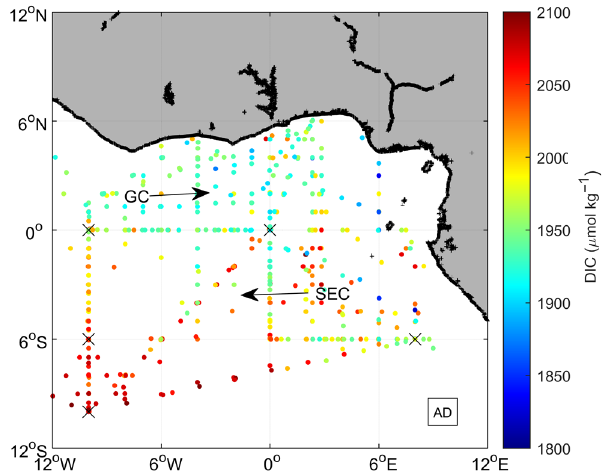
Figure 1. Distribution of DIC observations (2005–2019) and location of the five PIRATA moorings (×). The main zonal surface currents are the eastward Guinea Current (GC) and the westward South Equatorial Current (SEC). The location of the Angola Dome (AD) is indicated.